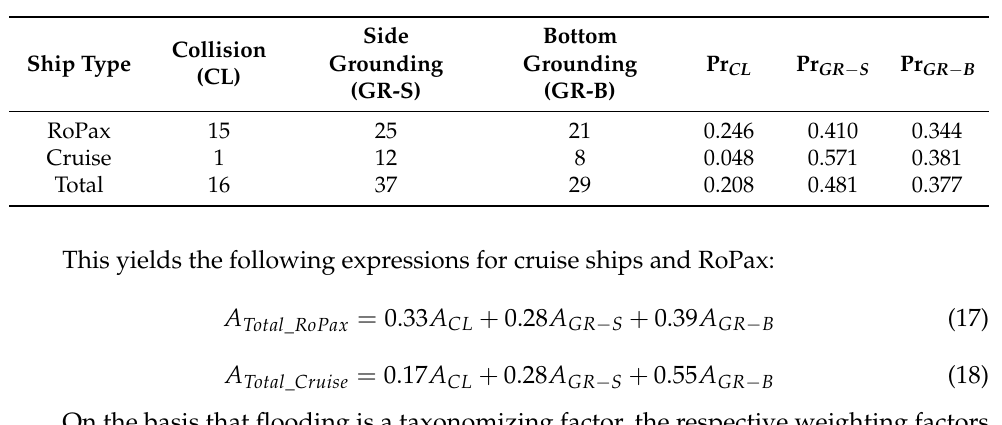
Table 3. Total number of accidents involving flooding and their respective weighting